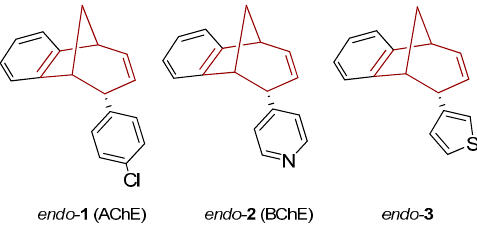
Figure 1. Photoproducts as potent inhibitors of BChE and AChE [24].